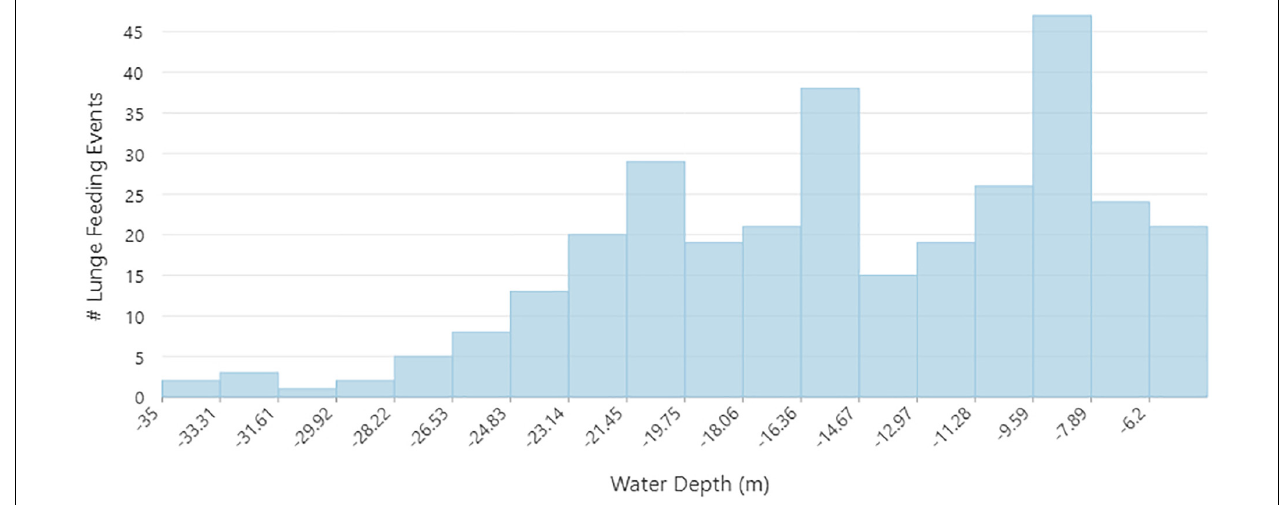
FIGURE 4 | Distribution of water depths for each lunge feeding event (2011–2019).